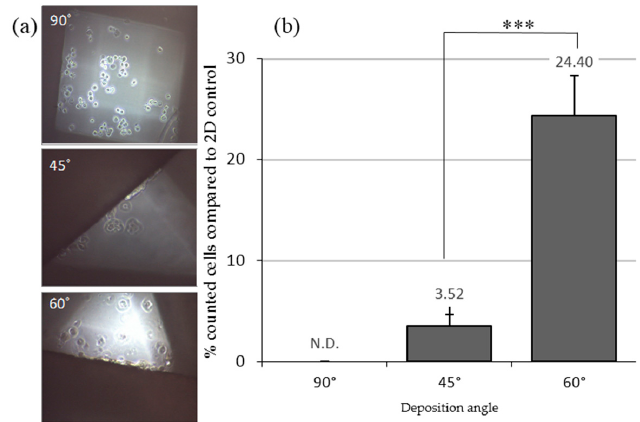
Figure 2. Cells cultured in 3D conditions with adherent well plates. ( a ) Inverted optical microscopy images of MCF7 cells seeded on different scaffold designs; ( b ) cells counted (%) three days after seeding in different deposition angle designed scaffolds. Results are shown as mean ± standard error. *** ( p < 0.001) indicates levels of statistically significance.